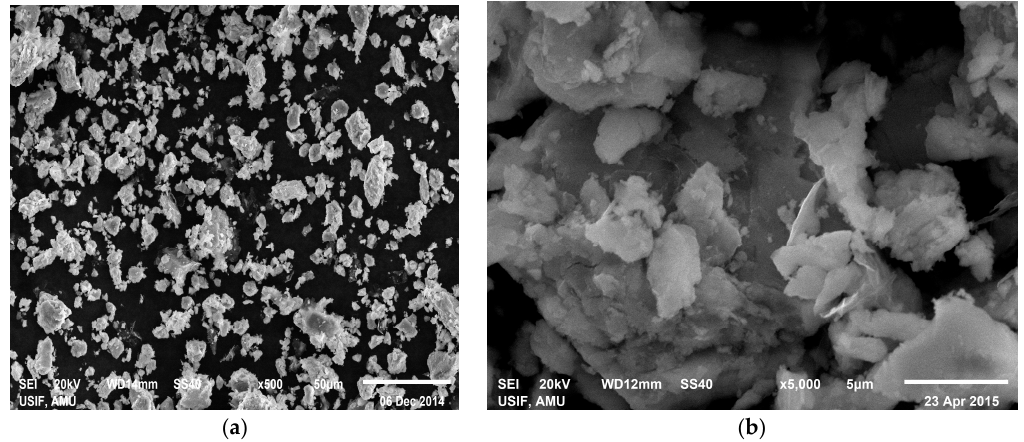
Figure 1. Scanning electron micrograph (SEM) of graphene Th(IV) phosphate cation-exchanger at different magnifications. ( a ) ×500, ( b ) ×5000.